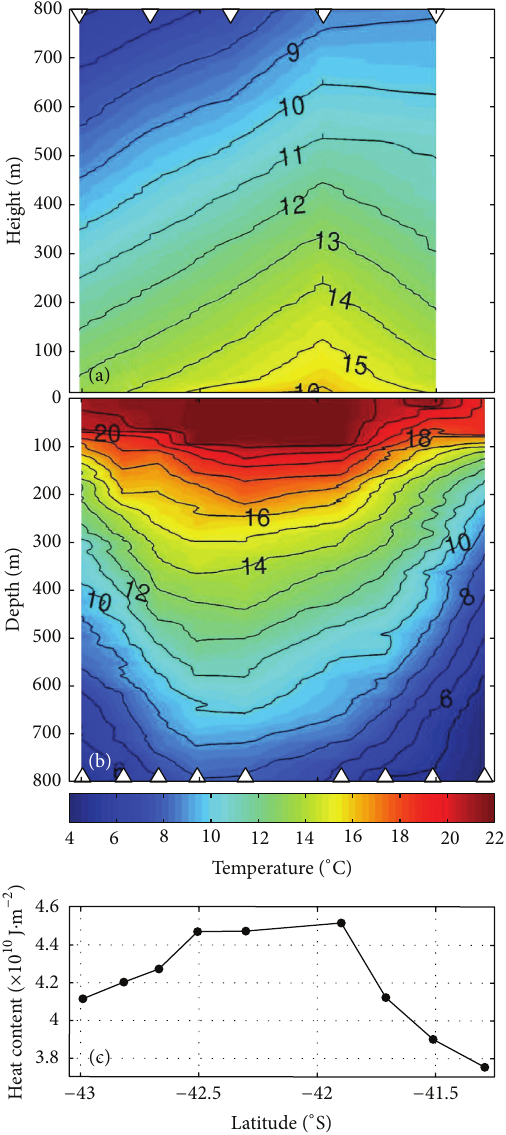
Figure 3: Ocean-atmosphere cross section of the warm eddy with heat content in the first 200 m of the ocean. (a) Atmosphere; (b) ocean. White triangles at the top are radiosounding release locations while white triangles at the bottom are XBTs release locations.